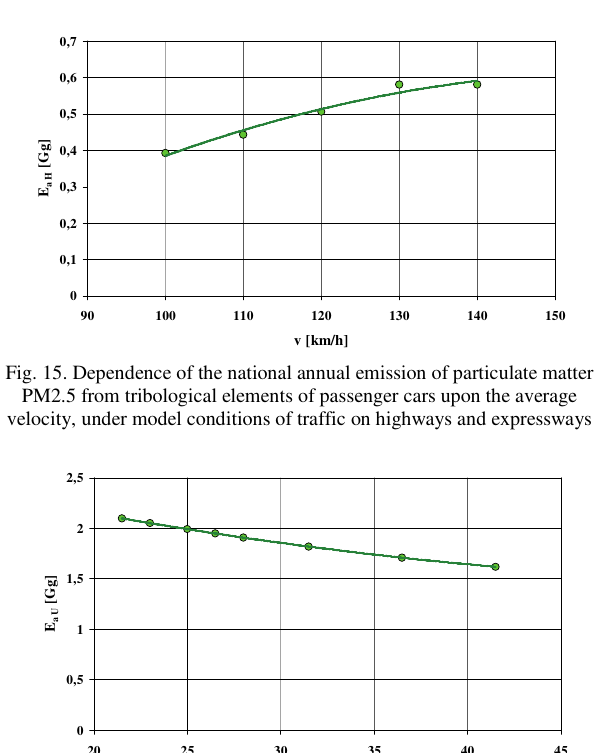
Fig. 18. Dependence of the national annual emission of particulate matter Fig. 14. Dependence of the national annual emission of particulate matter from the exhaust system of passenger car engines upon the average PM2.5 from tribological elements of passenger cars upon the average velocity, under model conditions of traffic on highways and expressways velocity, under model conditions of rural traffic